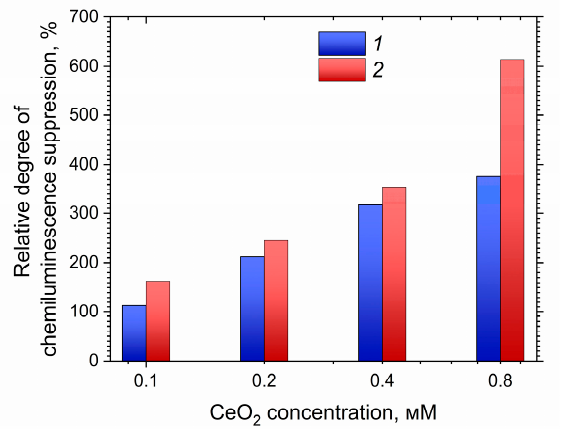
Figure 8. Comparison of the antioxidant activity of nanocrystalline CeO 2 sols stabilized with (1) octanoic and (2) 2-ethylhexanoic acids with respect to the superoxide anion radical.